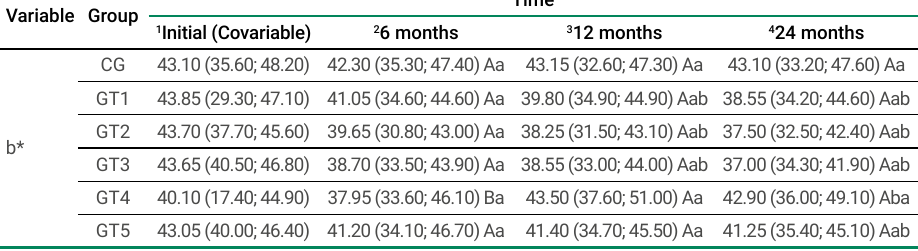
Analyzing the ∆L after 06, 12 and 24 months of simulated brushing, all the test groups showed higher ∆L than the CG. However there was no statistical difference in the three time periods studies between the test groups (Table 4).